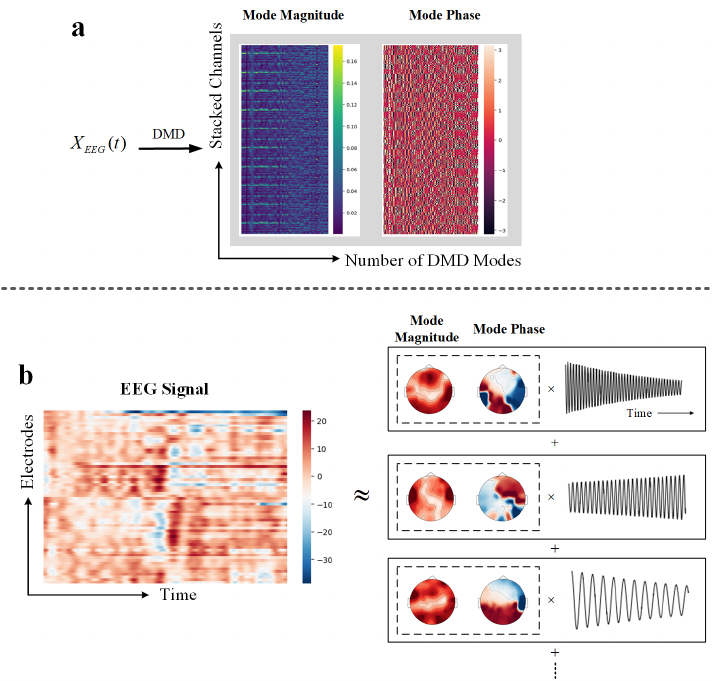
Figure 1. ( a ) The augmented EEG signals are converted into a matrix of magnitudes and phases that represents the complex values of the DMD modes matrix. ( b ) The illustration of EEG decomposition based on dynamic mode decomposition